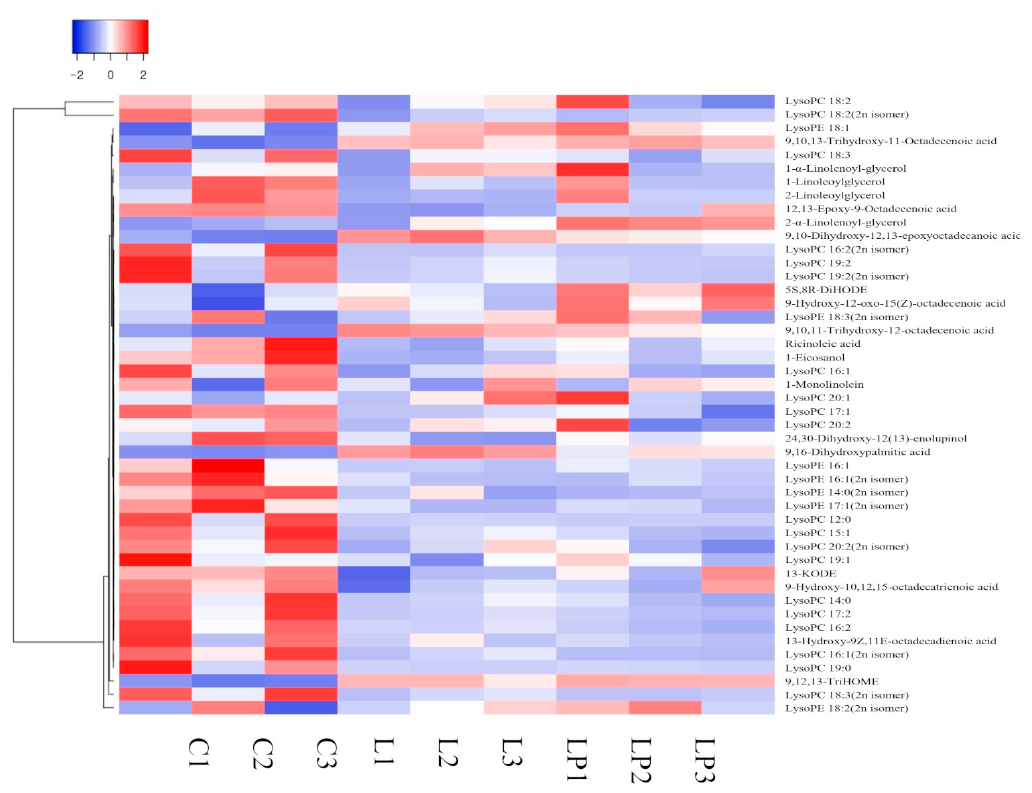
Figure 15. Heatmap and dendrogram of lipids metabolites in embryos of maize under exogenous proline and low-temperature stress treatments. Alkaloids Metabolites